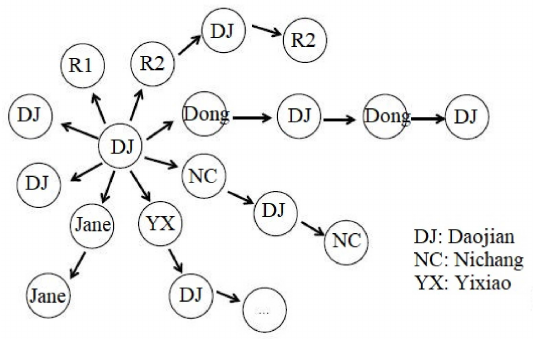
Figure 2. Sample of web-like patterns: multiple responses to a single